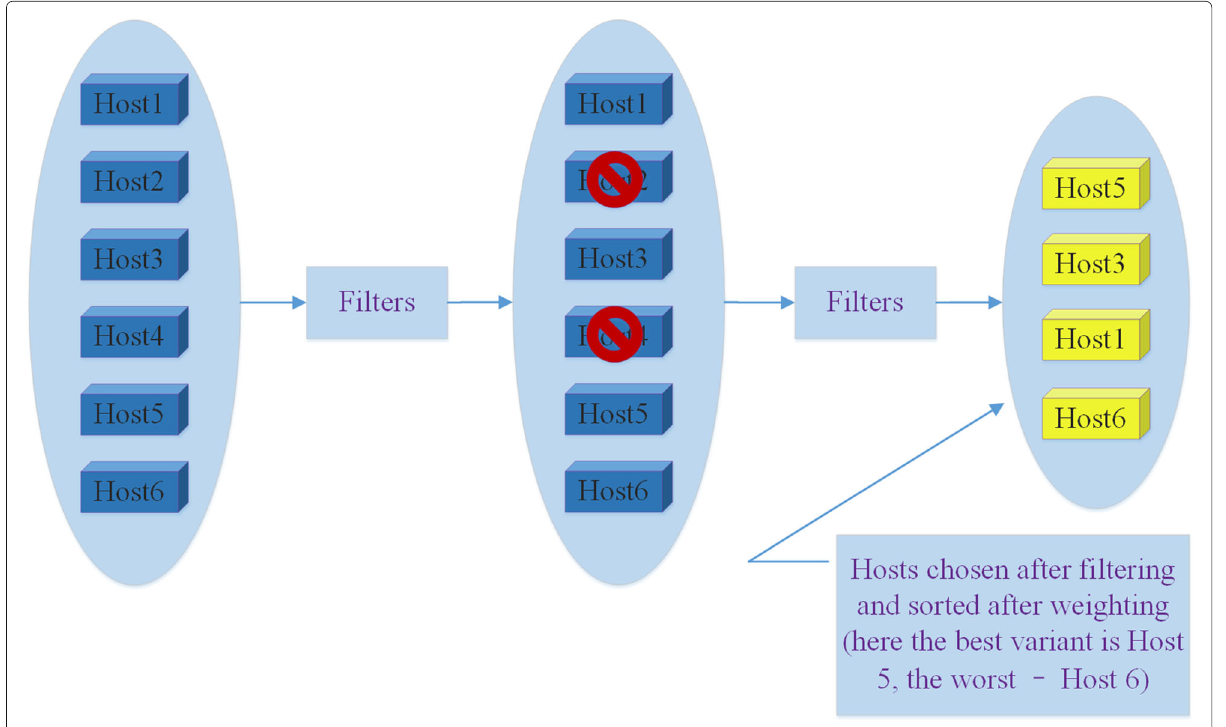
Fig. 1 The work process of filter